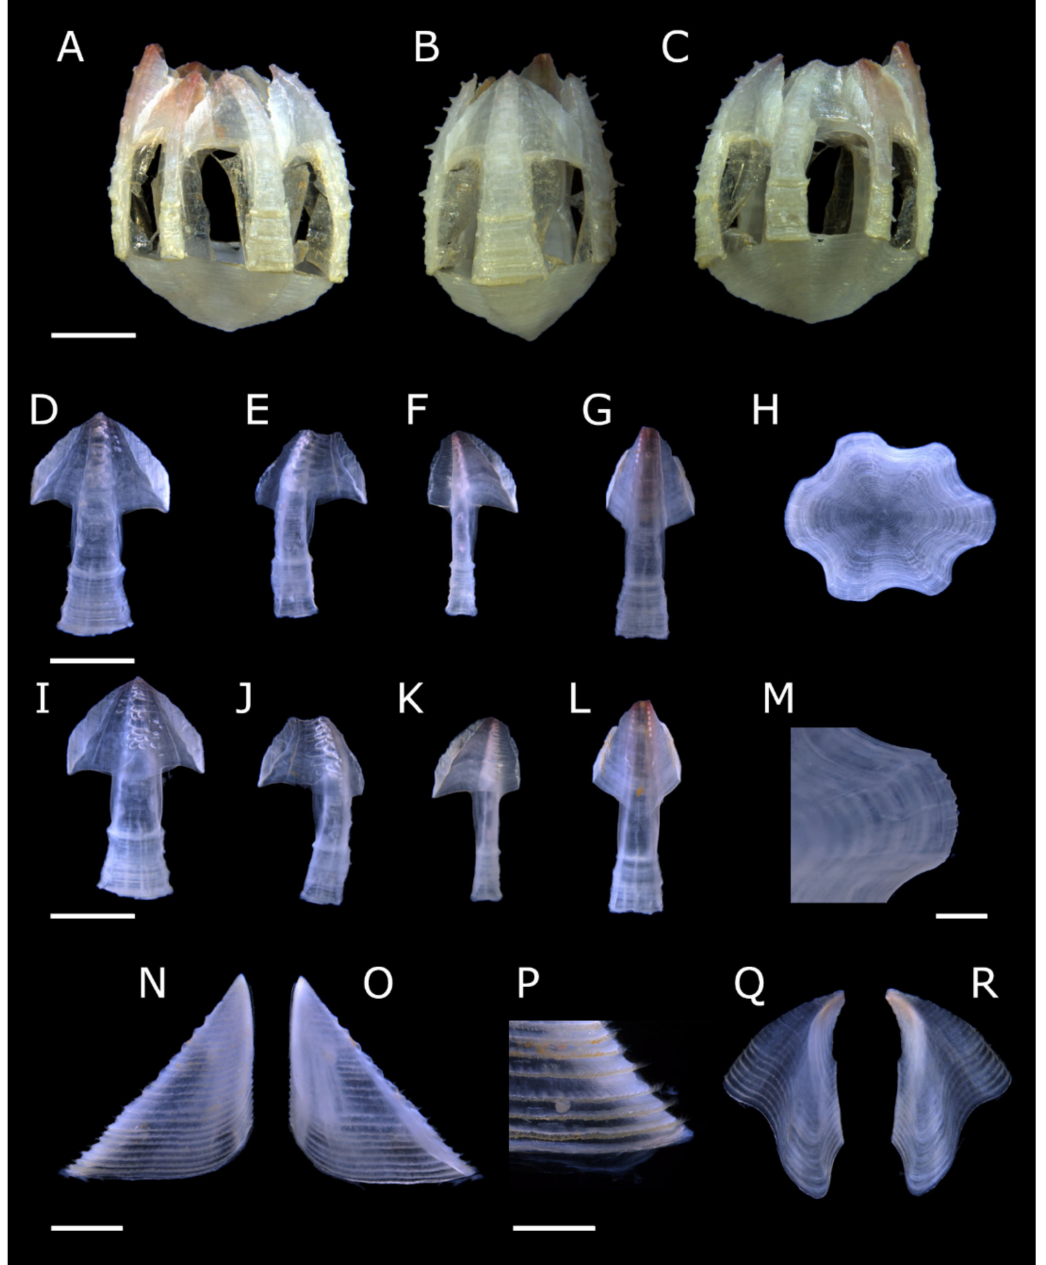
Figure 1. Acasta caveata sp. nov. shell plates (all WAM C 67716, holotype). ( A – C ) right, rostral, and left external views, respectively, of whole specimen; ( D – H ) external views of rostrum, right lateral, right carinolateral, carina, and basis; ( I – L ) internal views of rostrum, right lateral, right carinolateral, and carina; ( M ) close up of carinal portion of basis rim; ( N – O ) external and internal view of right scutum; ( P ) close up of growth lines on scutum showing setae; ( Q – R ) internal and external views of right tergum. Scale bars: A–L = 2 mm; M, P = 0.5 mm; N–O, Q–R = 1